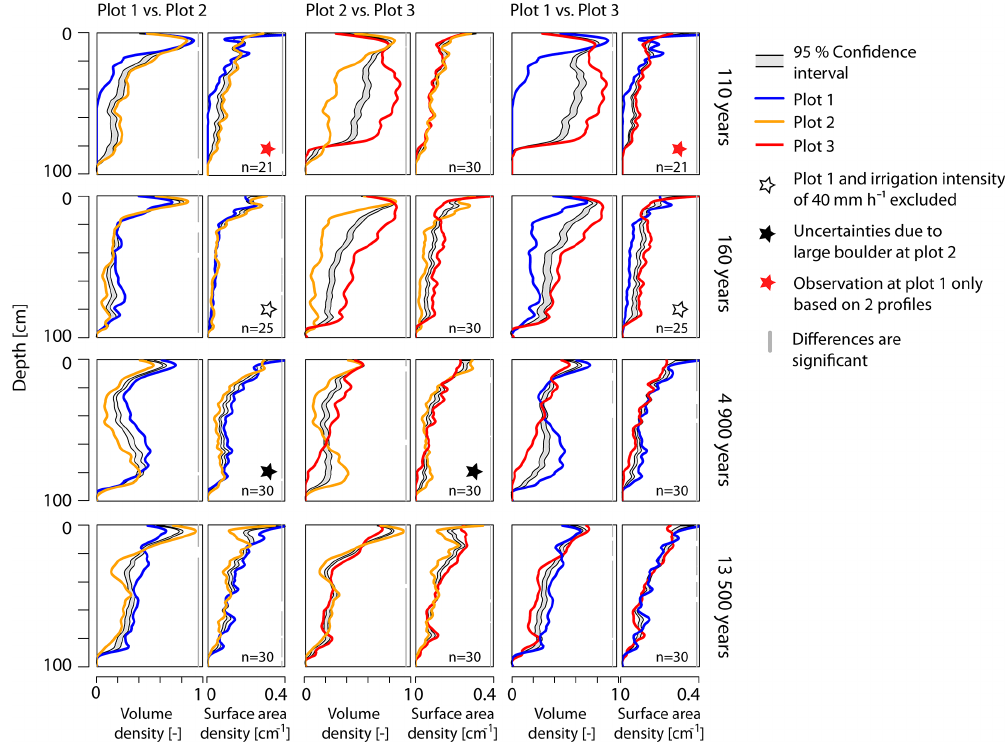
Figure 9. BLR test for differences in volume density profiles and surface area density profiles among the three experimental plots per age class. If the profile lines sit outside the gray-shaded confidence interval, the two profiles are considered to be significantly different. The parts of the depth profiles where this is the case are indicated by gray vertical bars on the right of each plot; n denotes the number of profiles used for the depth-wise